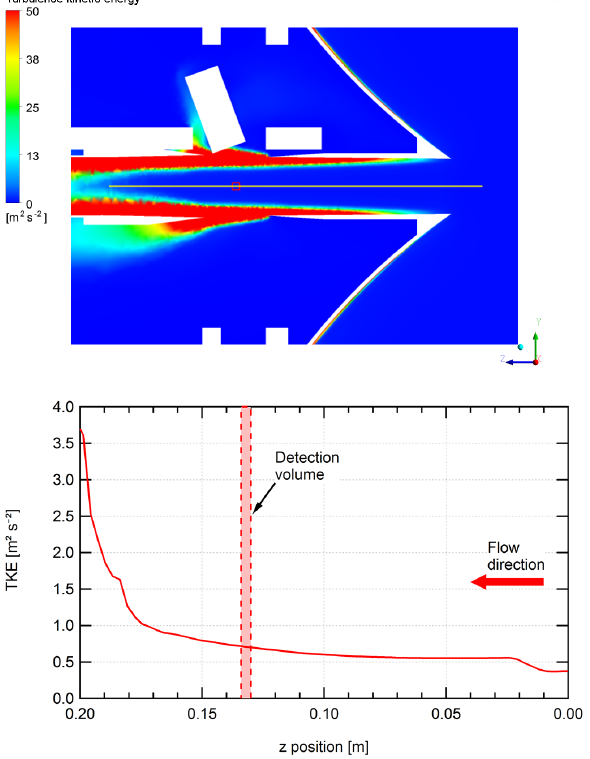
Figure 7. Upper panel: turbulence kinetic energy distribution within the particle flow tube of the probe. The red square marks the detec- tion volume. Lower panel: the TKE along the horizontal centre line trajectory (shown above) is only slightly increased compared to the background